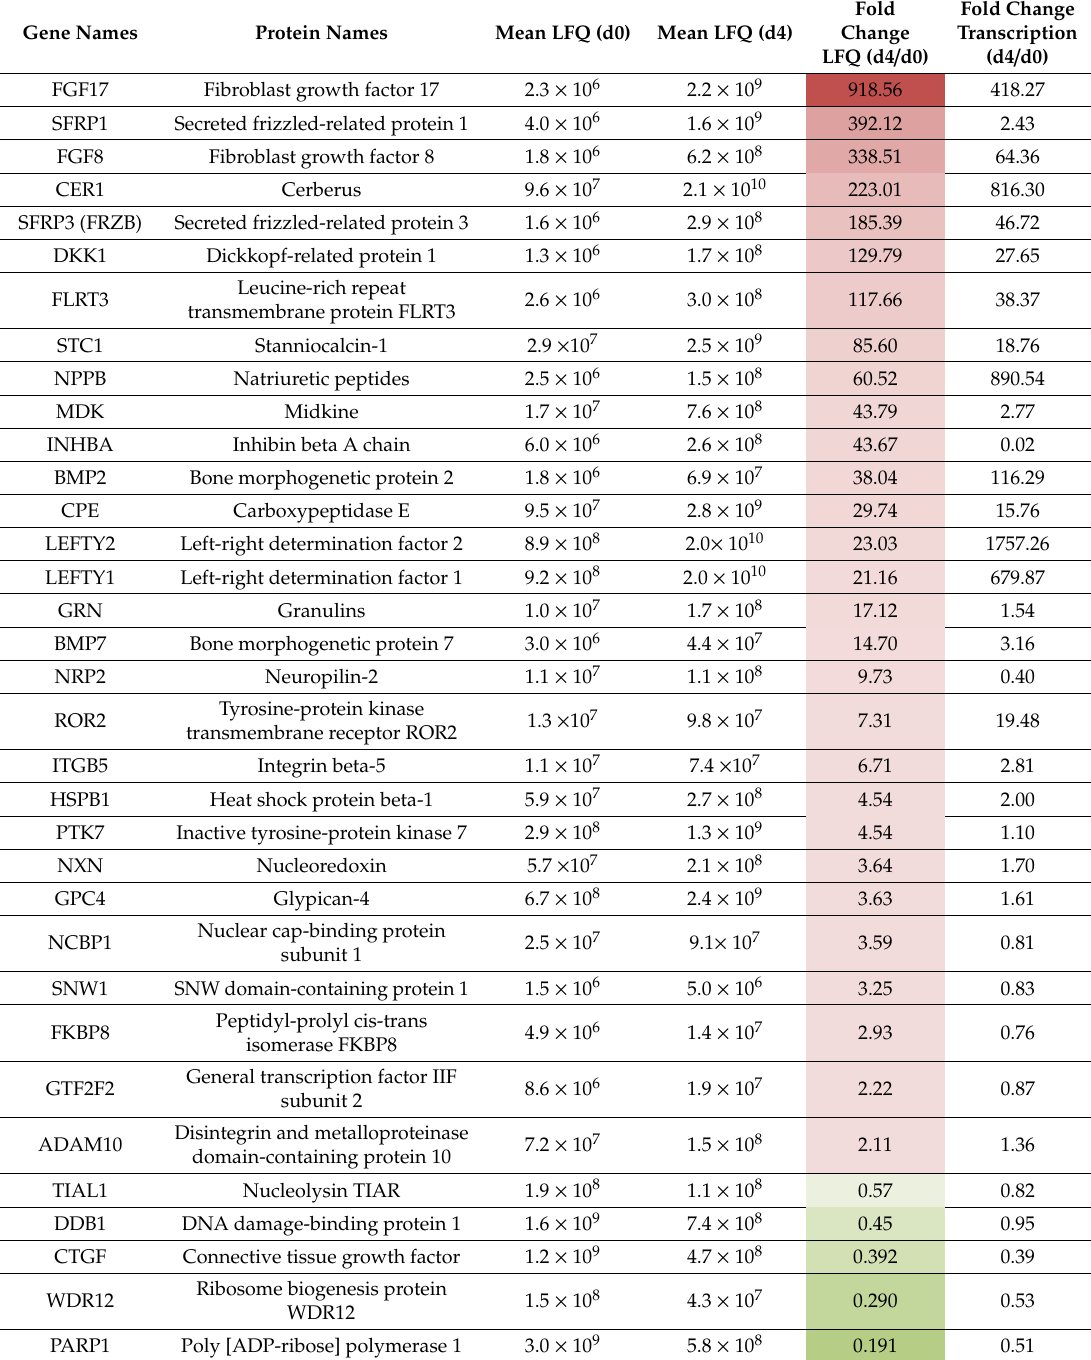
Table 1. Secreted signaling factors in hESCs and definitive endoderm (DE)